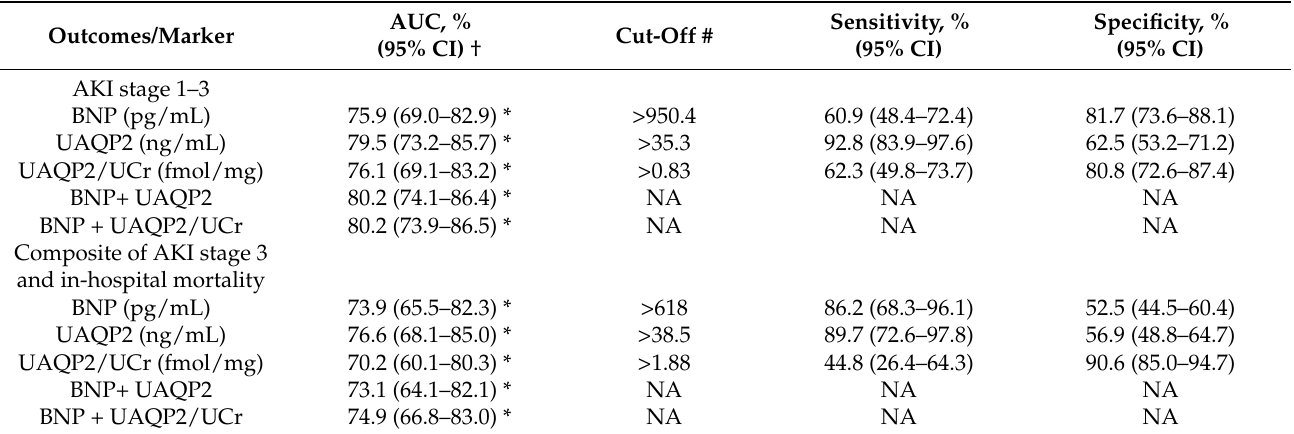
Table 4. Discriminating between AKI and the composite of AKI stage 3 and in-hospital mortality: receiver operating characteristic curve analysis of the biomarkers of heart failure and renal dysfunction.